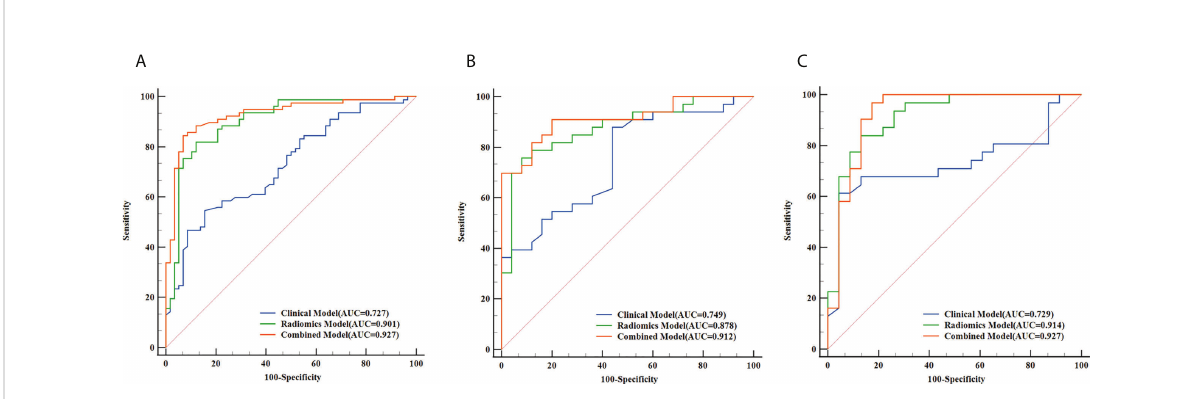
FIGURE 6 The receiver operating characteristic (ROC) curves of the clinical model, the radiomics model (T2WI+SVM) and the combined model in the training set (A) , test set 1 (B) and test set 2 (C) ,